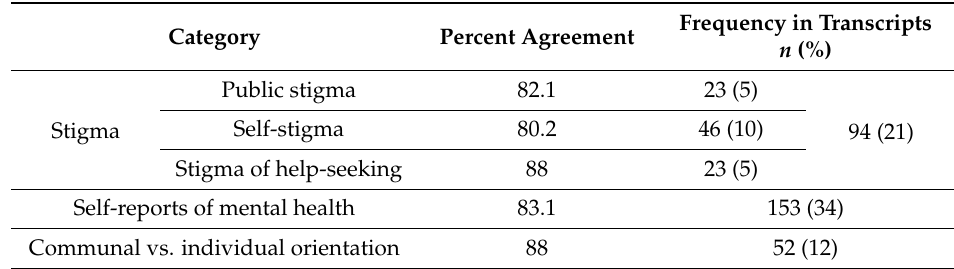
Table 3. Percentage agreement between coders and percentage of passages in which coding categories appeared (See Appendix A for all coding